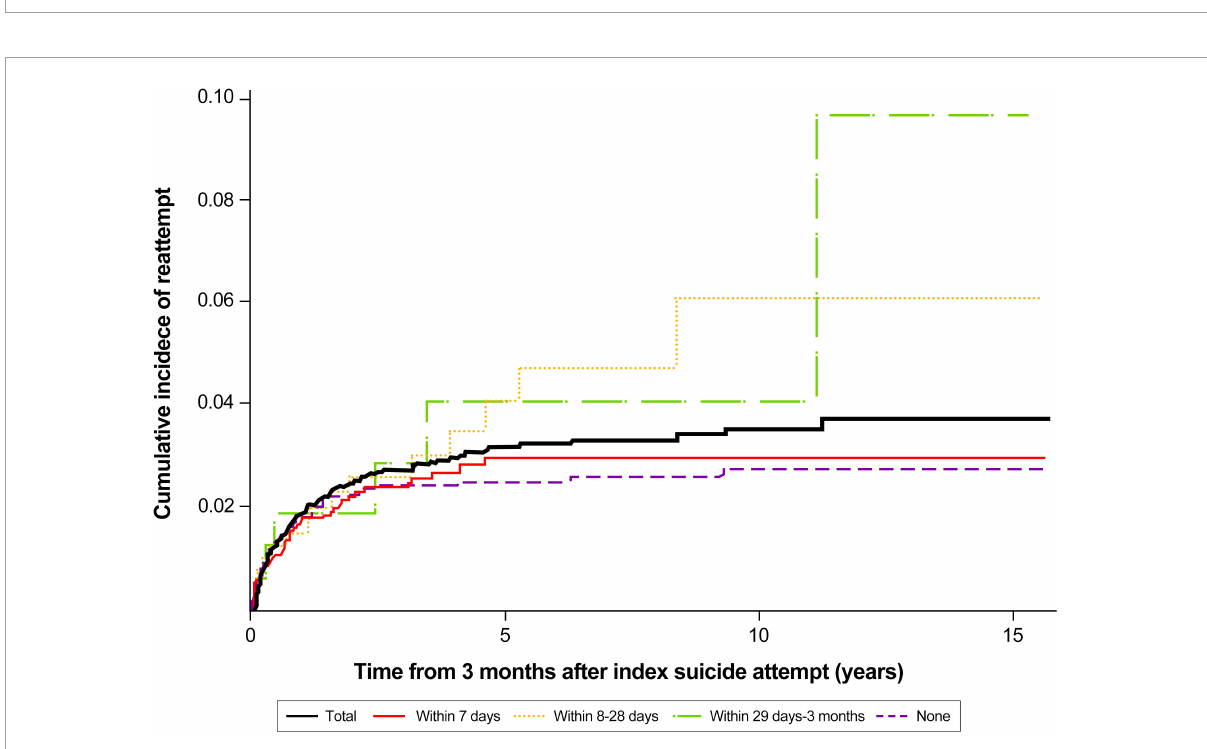
FIGURE2 Cumulative incidence of suicide reattempt after index suicide attempt according to the timing of referral to